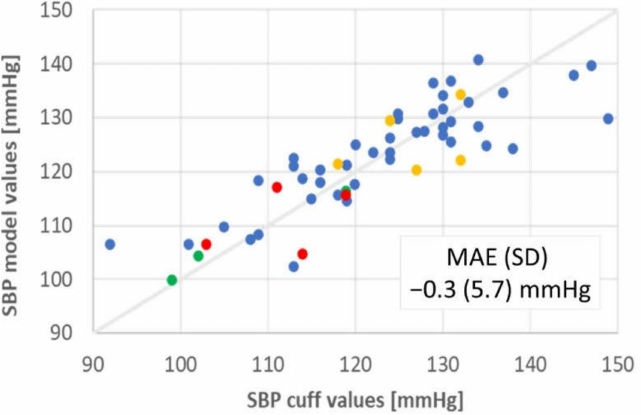
Figure 5. Results from convolutional neural network model trained with cuff data from Study 1 and tested with an ambulatory blood pressure monitor for 4 other ambulatory subjects (SBP values color coded by